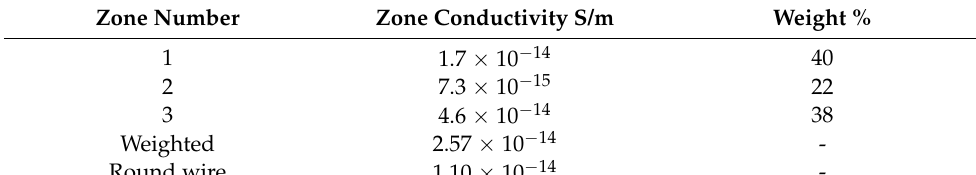
Table 2. Electrical conductivity in different zones.